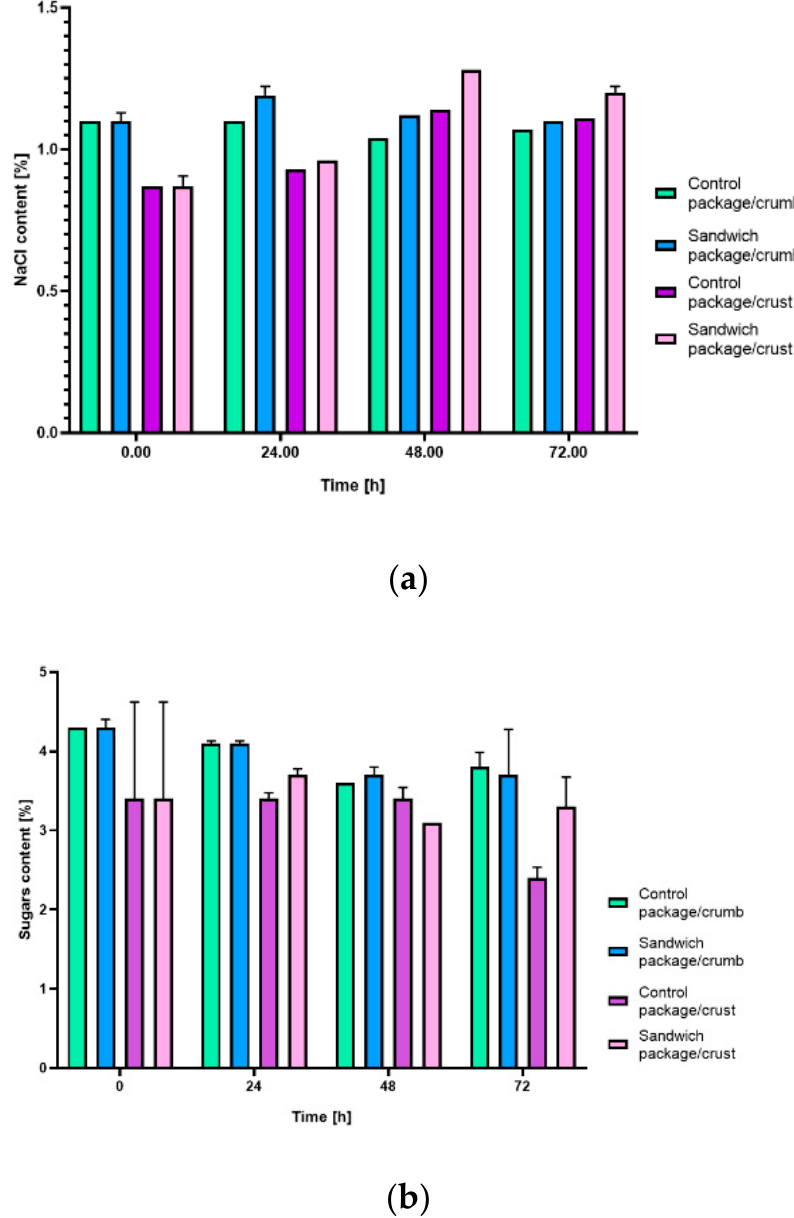
Figure 8. ( a ) NaCl content in the bread after storage in paper and in the modified package. ( b ) Sugar content in the bread after storage in paper and in the modified package. Fresh bread was characterised by a high sensory quality, showing a maximum score value of 4. After 24 h of storage, the score value decreased to 2.7 for bread stored in paper packaging, while in the case of bread stored in the sandwich packaging, this only decreased to 3.6 (Figure 9). After 48 h of storage, the influence of packaging modification on the sensory quality of bread was found to be higher. According to the sensory quality evaluation (Figure 9), paper packaging gave a strong objectionable smell and taste, and the scores fell dramatically after 72 h of storage (scores value 1.1), while sandwich packaging did not markedly decrease the sensory quality of the bread (a score value of 2.5). The di ff erences between score values for bread stored in sandwich packaging and in paper packaging were found to be significant ( p <